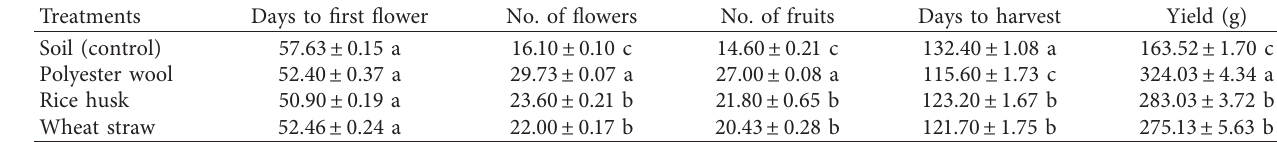
Table 3: Effect of different growth substrates on reproductive growth of strawberry cv. Chandler. Treatments